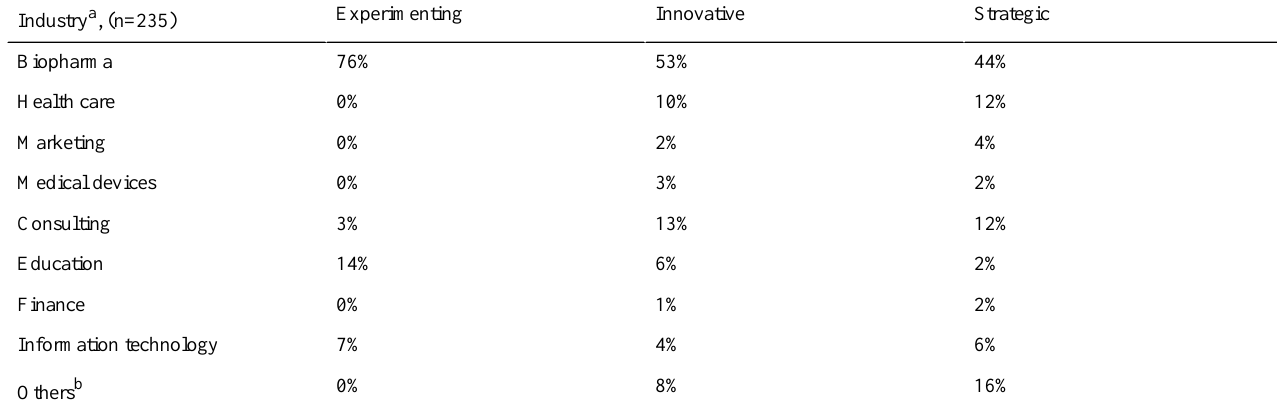
Table 2. Digital health leadership backgrounds. StrategicInnovativeExperimentingIndustry a ,